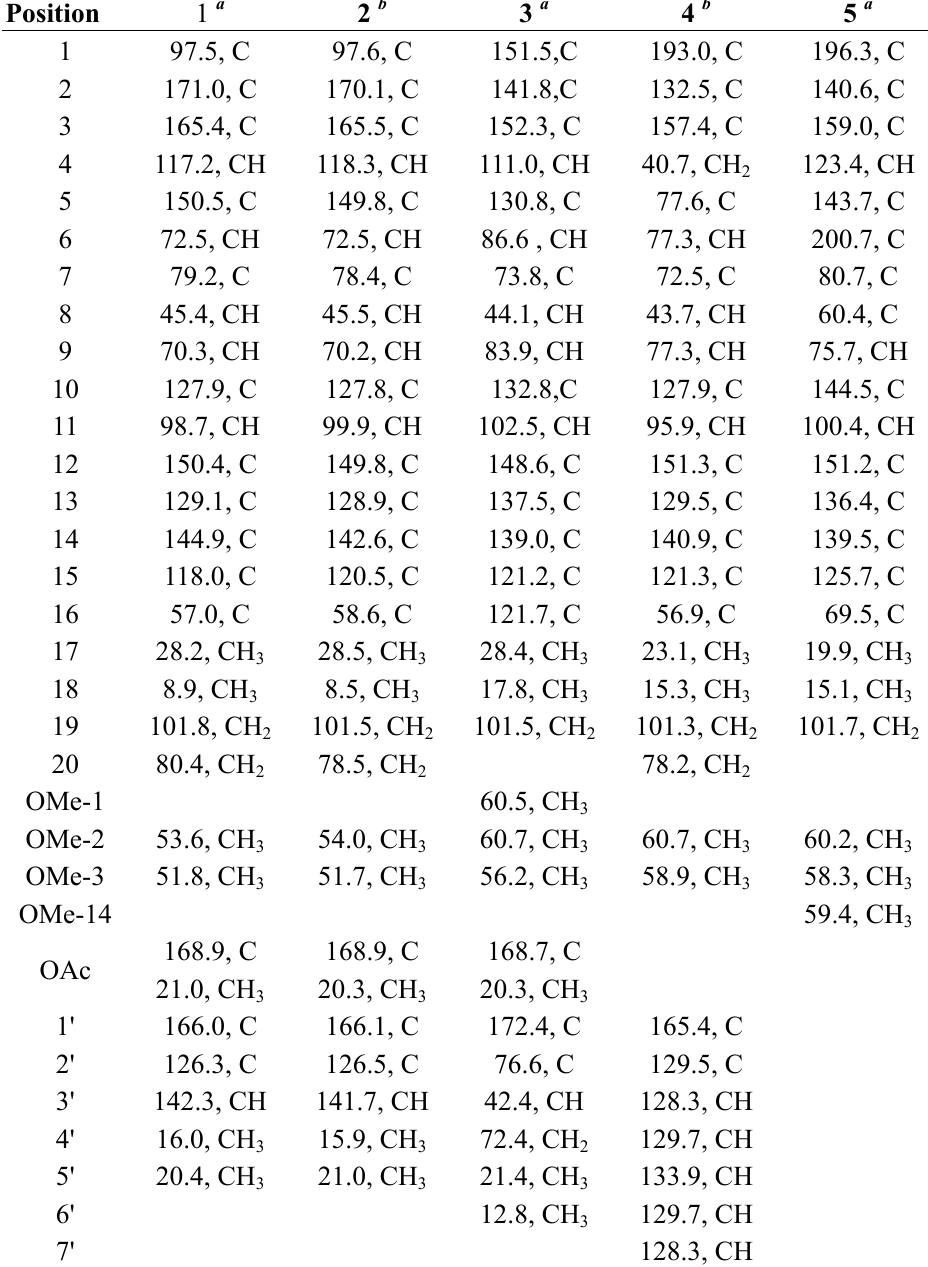
) of compounds 1 – 5 a,b . 3